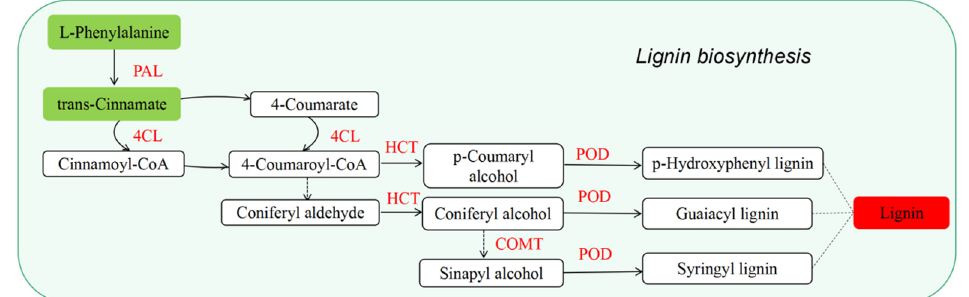
Figure 9. Regulation of blue light on the lignin synthesis pathway. PAL, phenylalanine ammonia- lyase; 4CL, 4-coumarate-CoA ligase; HCT, spermidine hydroxycinnamoyl transferase; COMT, caffeic acid 3-O-methyltransferase; POD, peroxidase. The red solid block indicates that lignin content was increased under the blue light; and the green solid block indicates that the expression of differential metabolites was decreased. Red text indicates upregulation of protein expression.